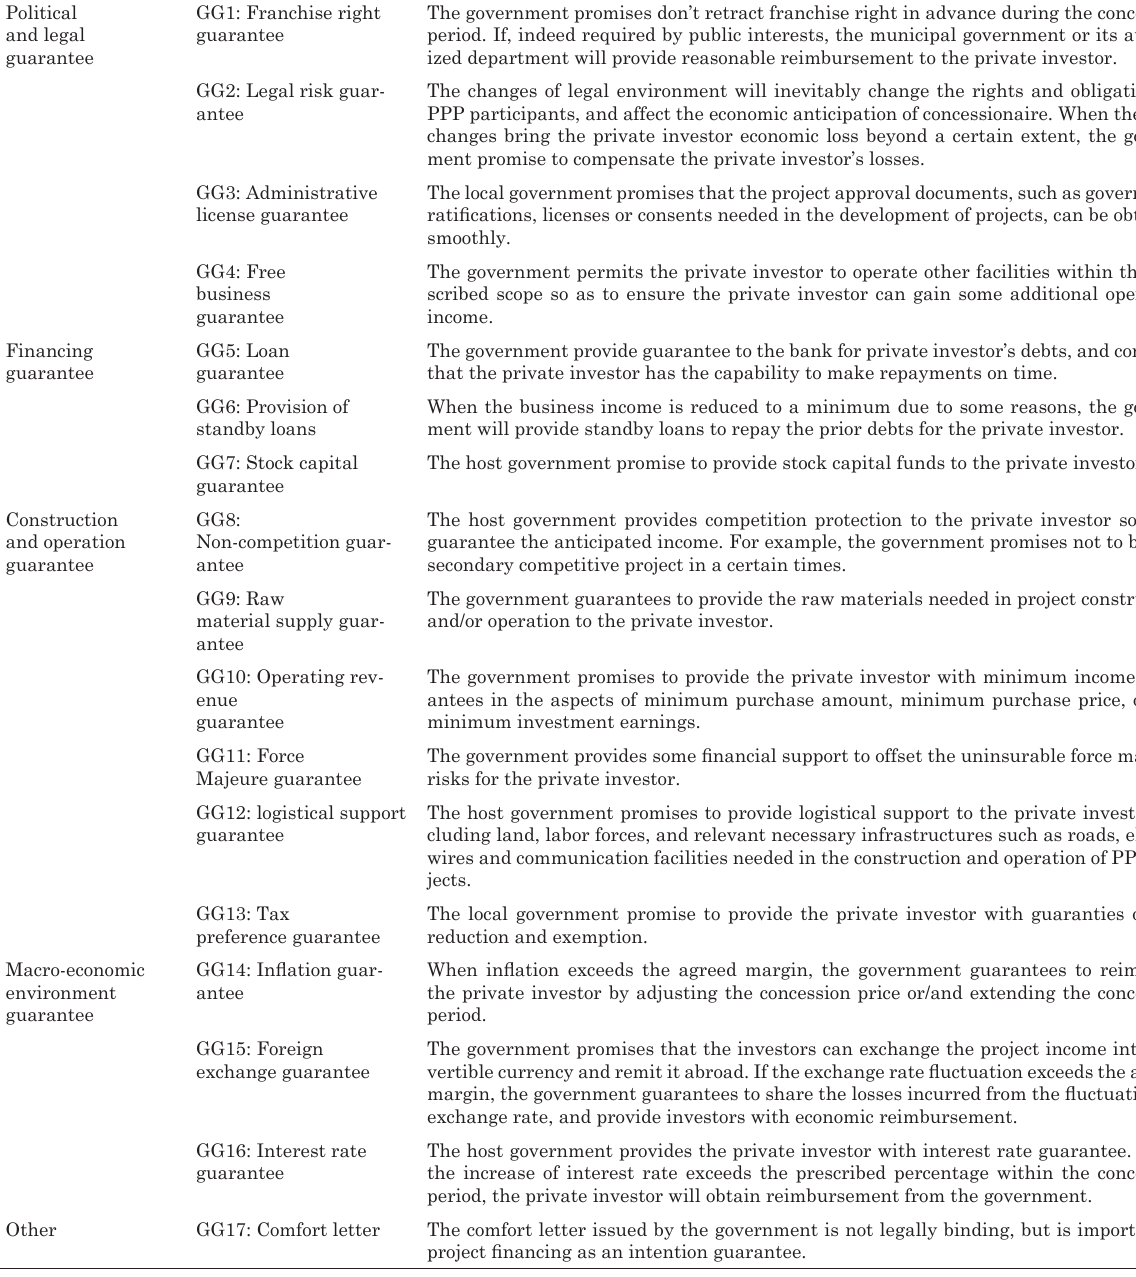
Table 1. A summary of government guarantees (GG) in PPP concession contract Political and